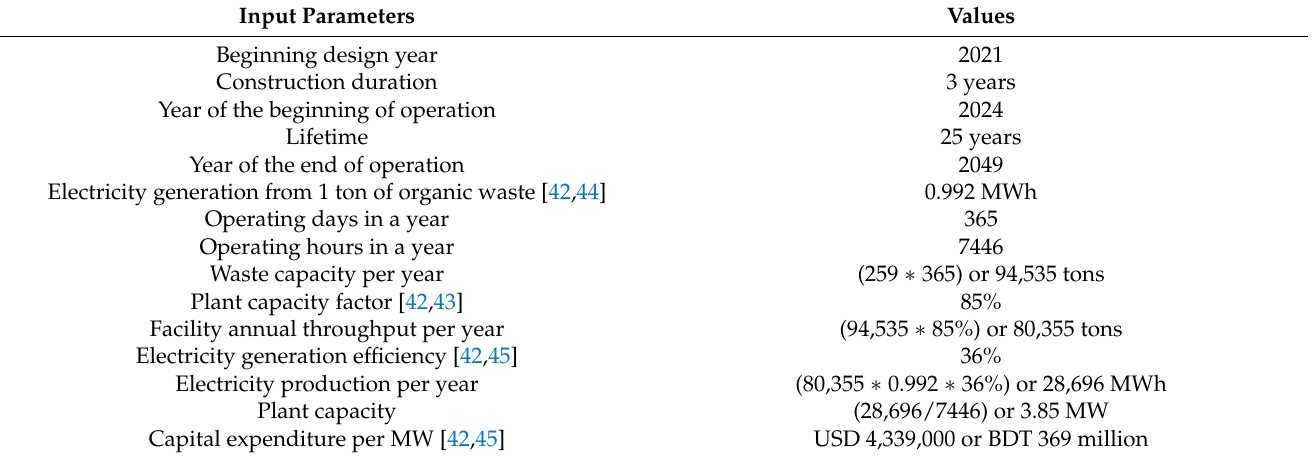
Table 11. Techno-economic analysis of anaerobic digestion